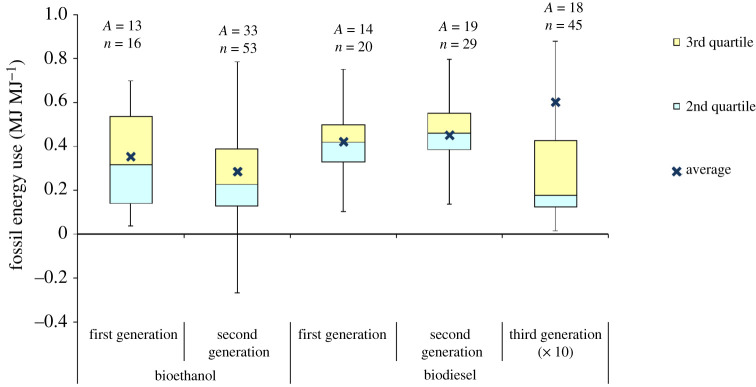
Fossil energy use in the life cycle of biofuels. Based on data from [17–19,40,47,48,54,55,57,58,60,68,76,77,80,85,89,92,93,95,96,98,108,113–115,120,121,129,132,133,136,138,139,143,144,147,152–154,156,159,161,162,164–167,169–171,175,176, 179–181,187,190–192,195–199,204,206,208,219–223]. For the box plot legend, see electronic supplementary material, figure S1 and for the data used to plot this graph, see electronic supplementary material, figure S7. The value for third-generation biodiesel should be multiplied by 10 to obtain the actual value. ‘A’ refers to the number of LCA articles found in the literature and ‘n’ denotes the total number of analyses. (Online version in colour.)